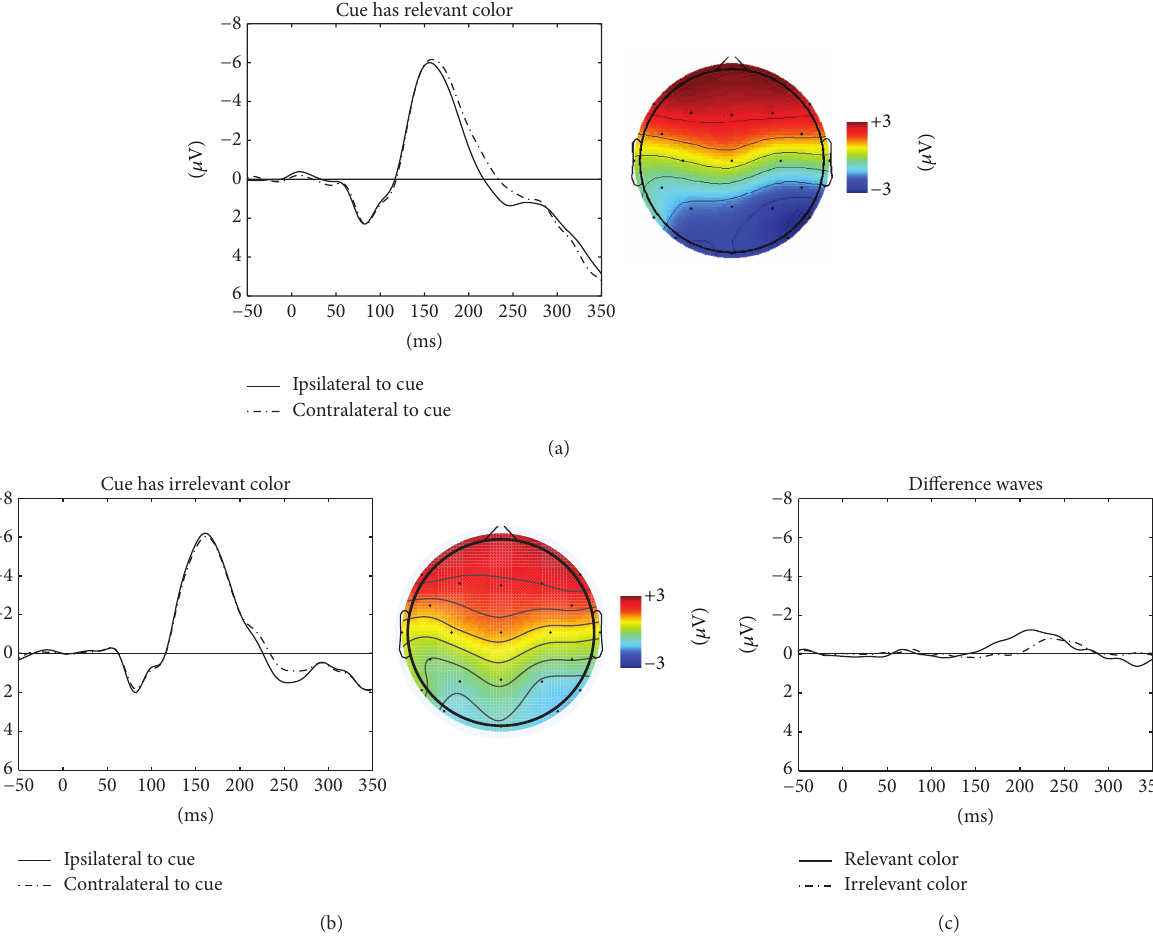
Figure 3: (a) ERPs (in 𝜇 Volts on the 𝑦 -axis) ipsilateral to the relevant cue (solid line), contralateral to the relevant cue (dashed line) as a function of the time since cue onset (at zero) on the 𝑥 -axis, and scalp distribution plots of mean ERP activity in response to the cues in a time window of 160 to 270 ms after the cue, with contralateral activity to the right and ipsilateral activity to the left and with negative values in blue and positive values in red. (b) The same as (a) for irrelevant cues. (c) Difference waves of contralateral minus ipsilateral activity, separately for relevant cues (solid line) and for irrelevant cues (dashed